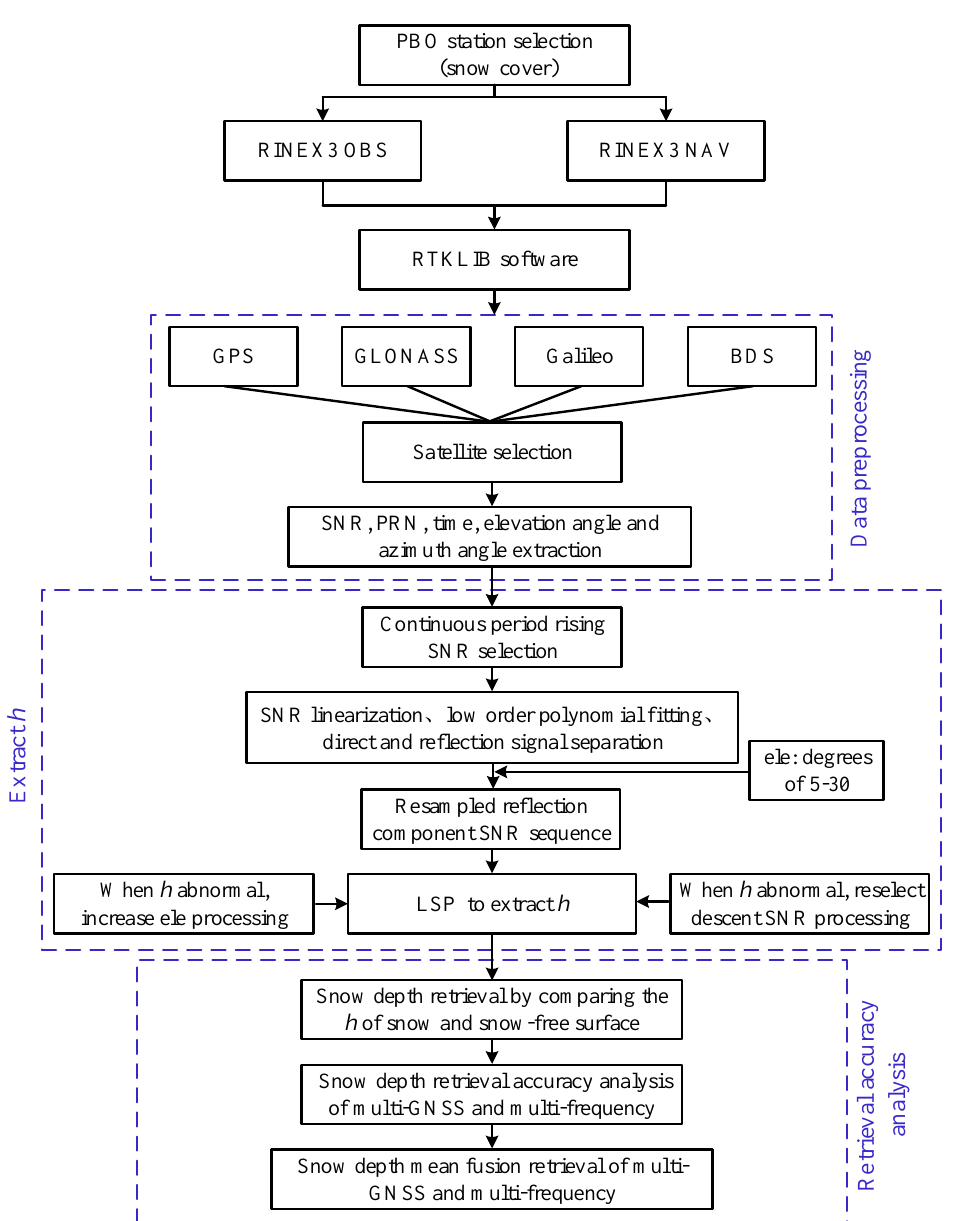
Figure 6. The technical process of multi-GNSS and multi-frequency GNSS-IR snow depth retrieval. Among the ele is the satellite elevation angle.